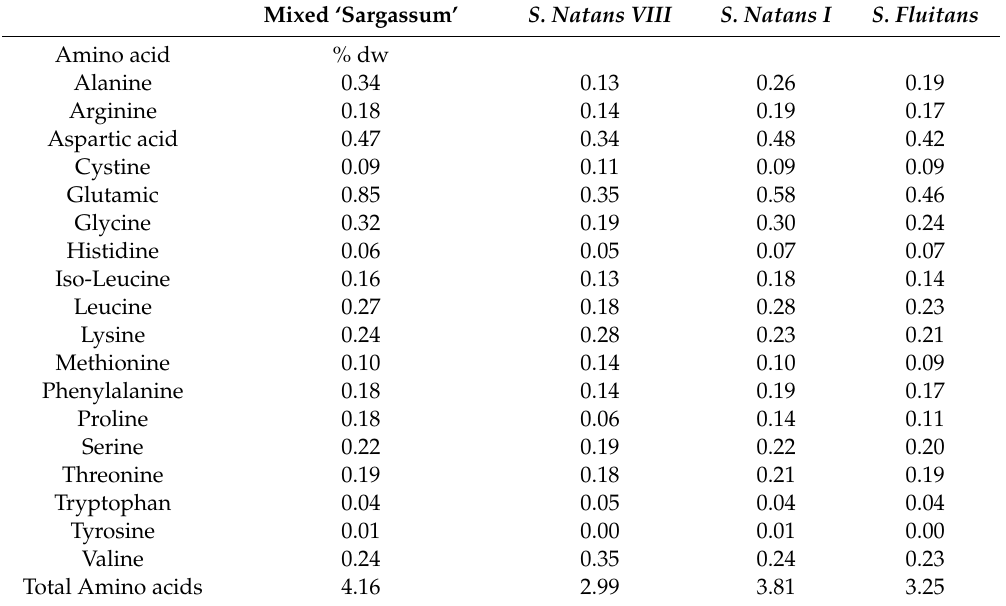
Table 7. Percentage of amino acids (AAs) in dry samples of Sargassum inundation (‘Mixed Sargassum’) and pelagic species of Sargassum from Turks and Caicos ( n = 1).